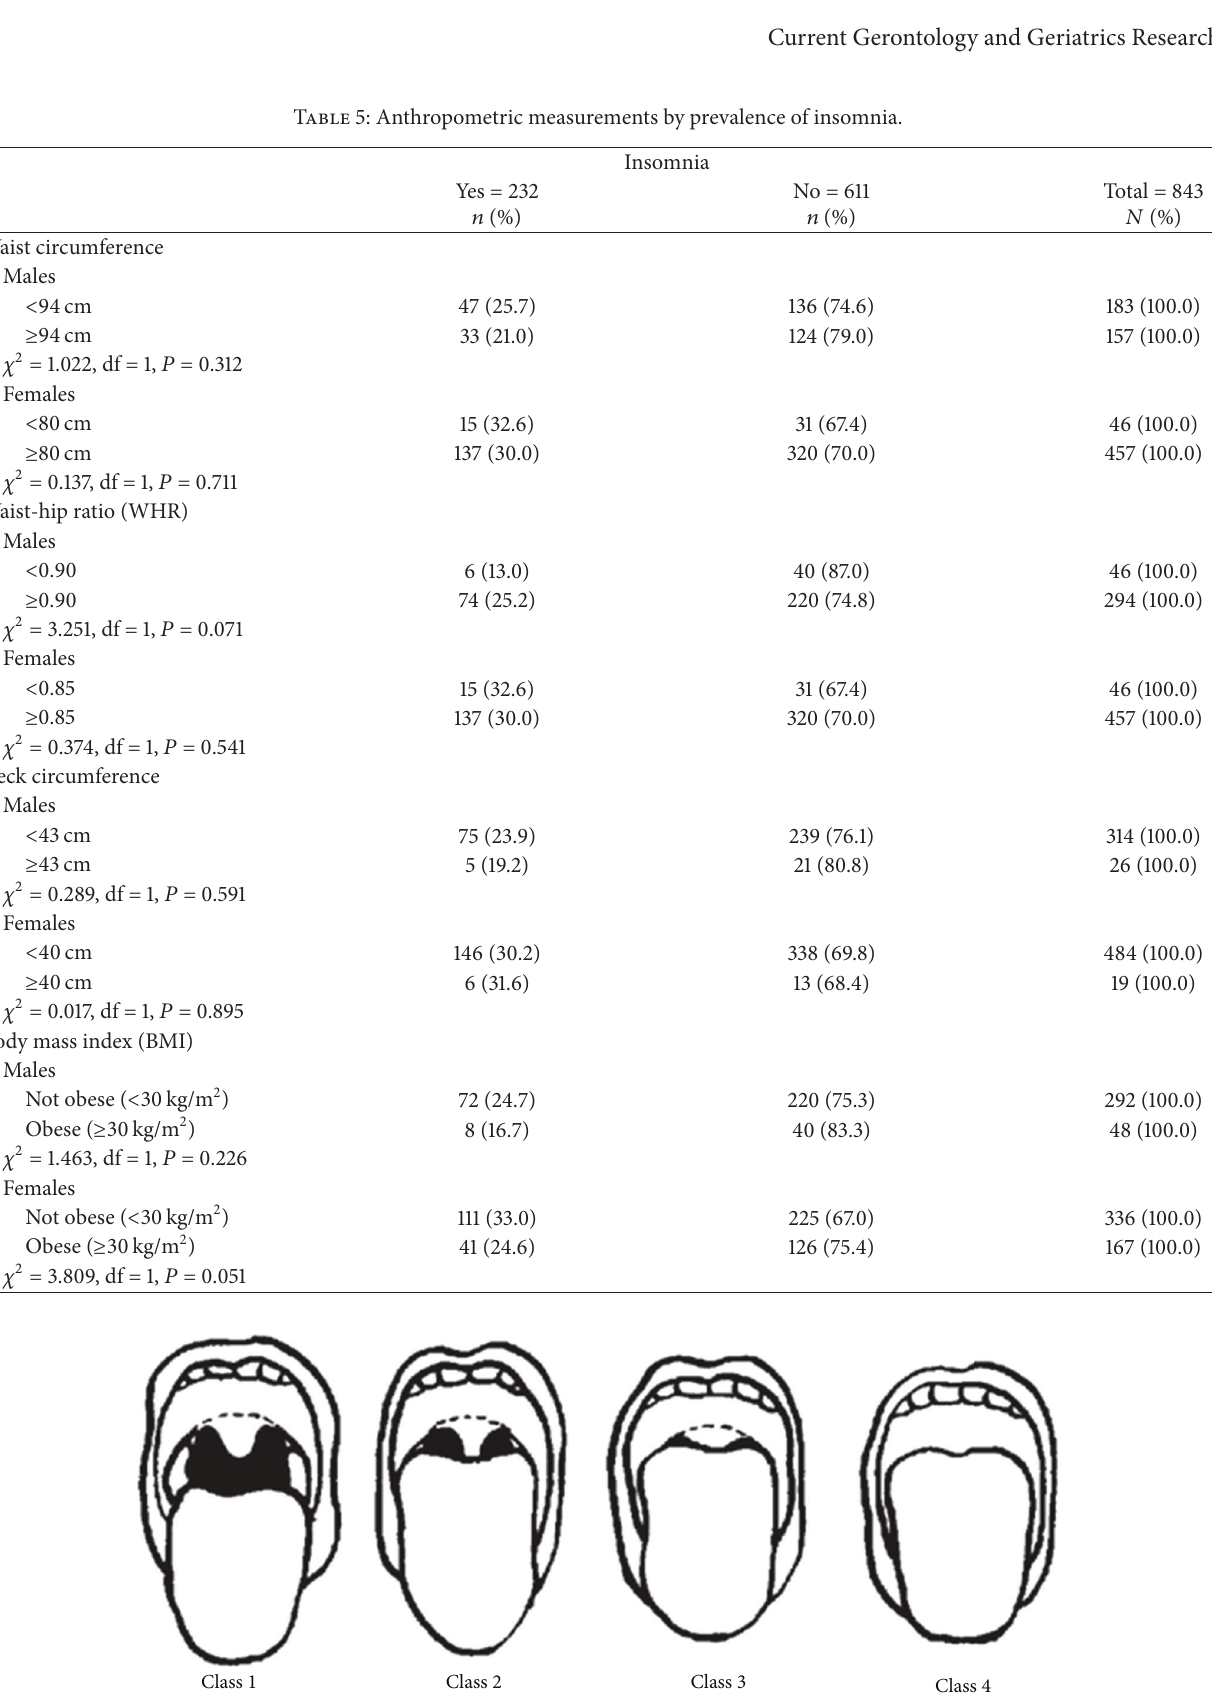
Figure 2: Oropharyngeal crowding (Mallampati